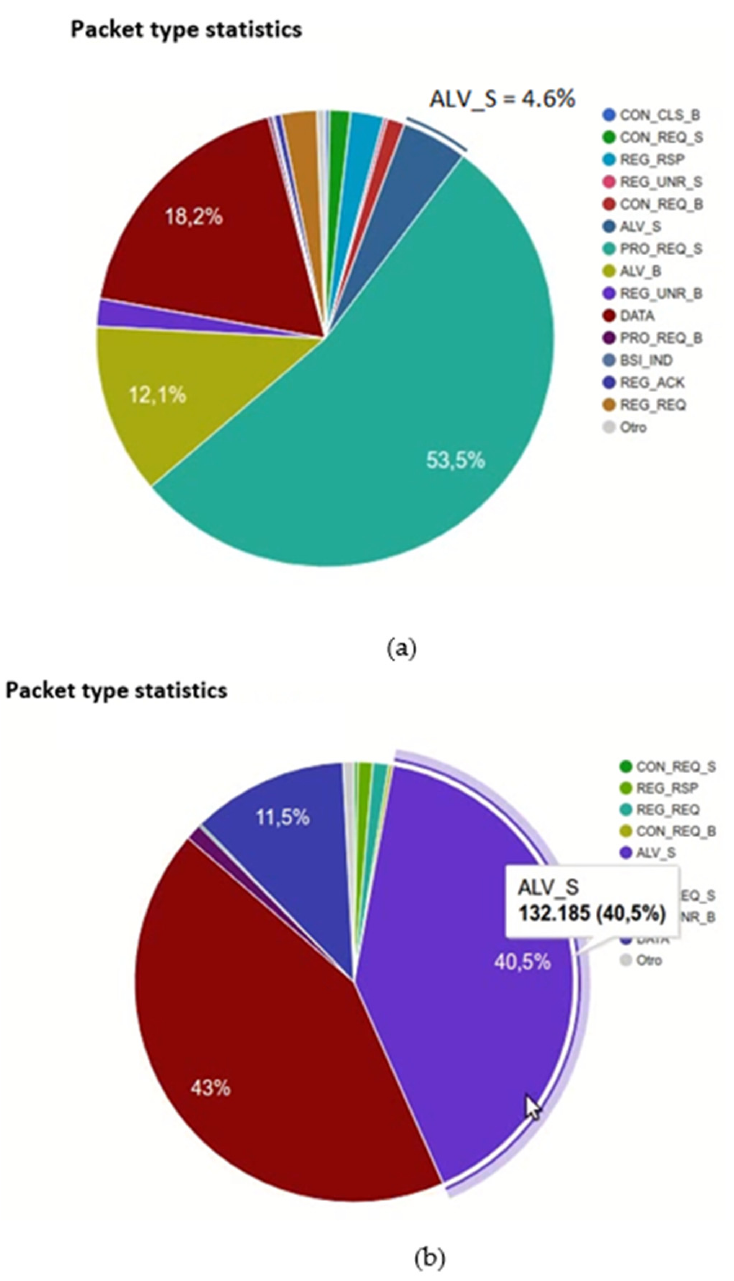
Figure 13. Graphs of types of packets for: ( a ) a problematic scenario and ( b ) a non-problematic sce- nario.